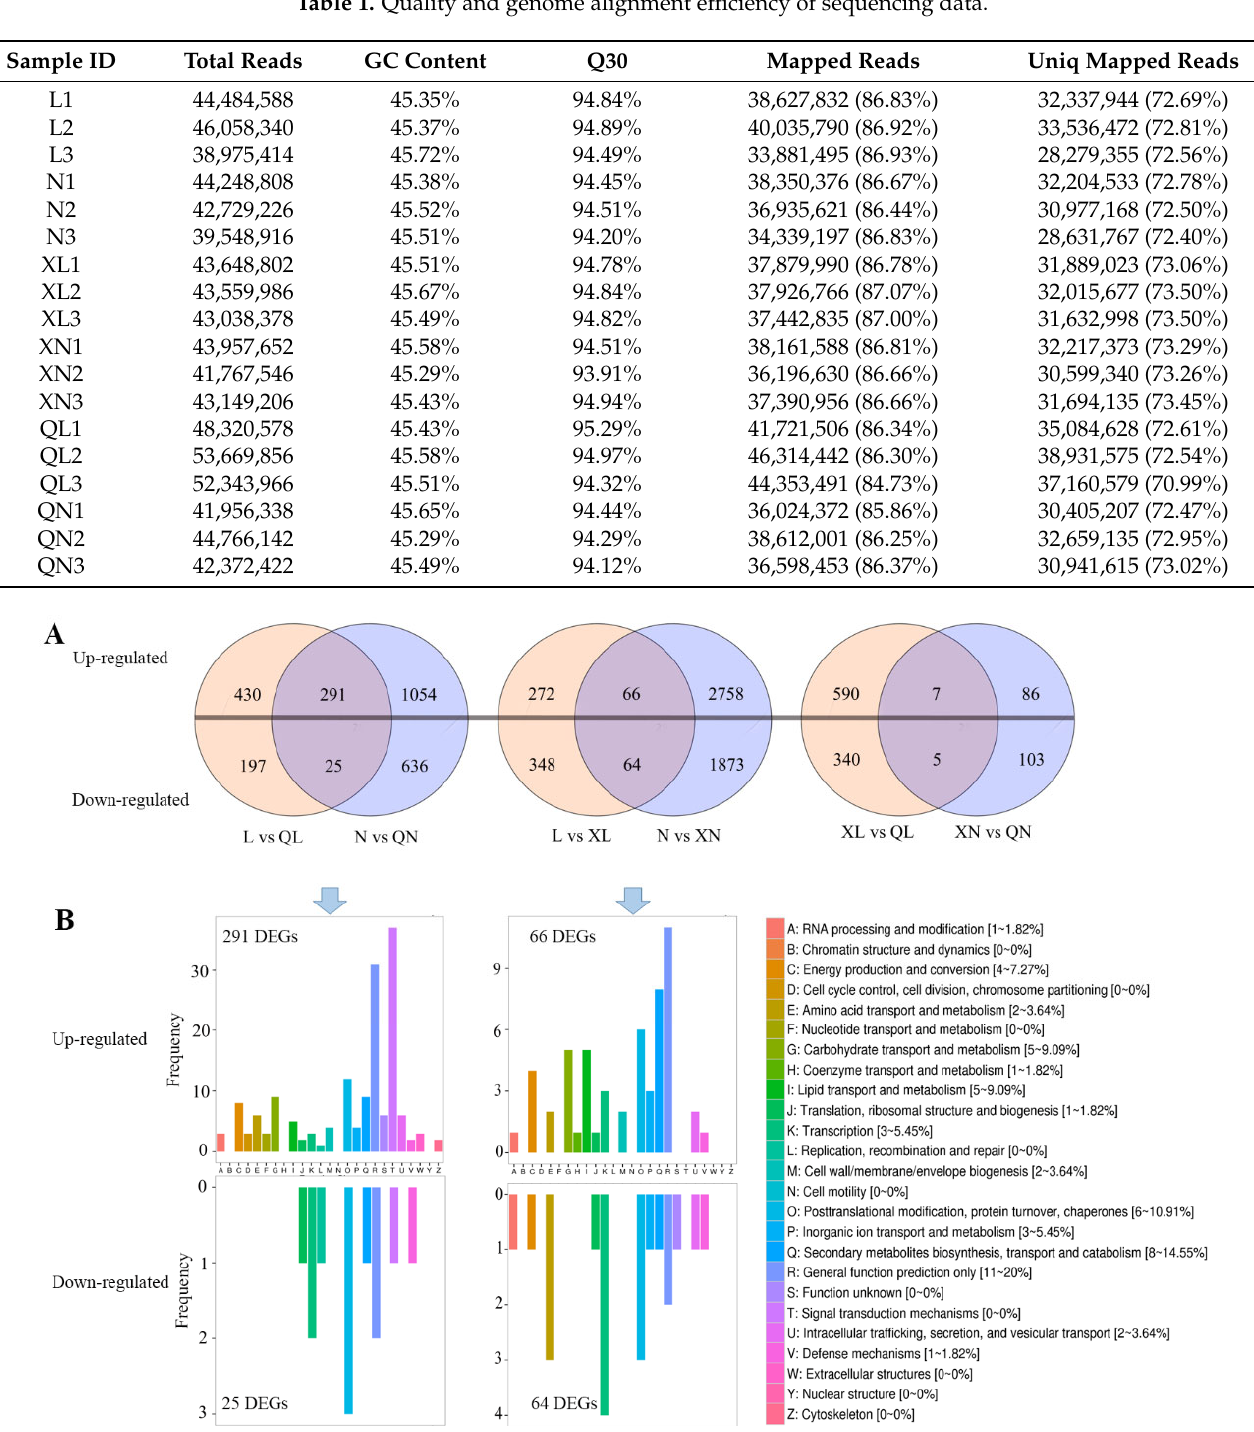
Table 1. Quality and genome alignment efficiency of sequencing data.